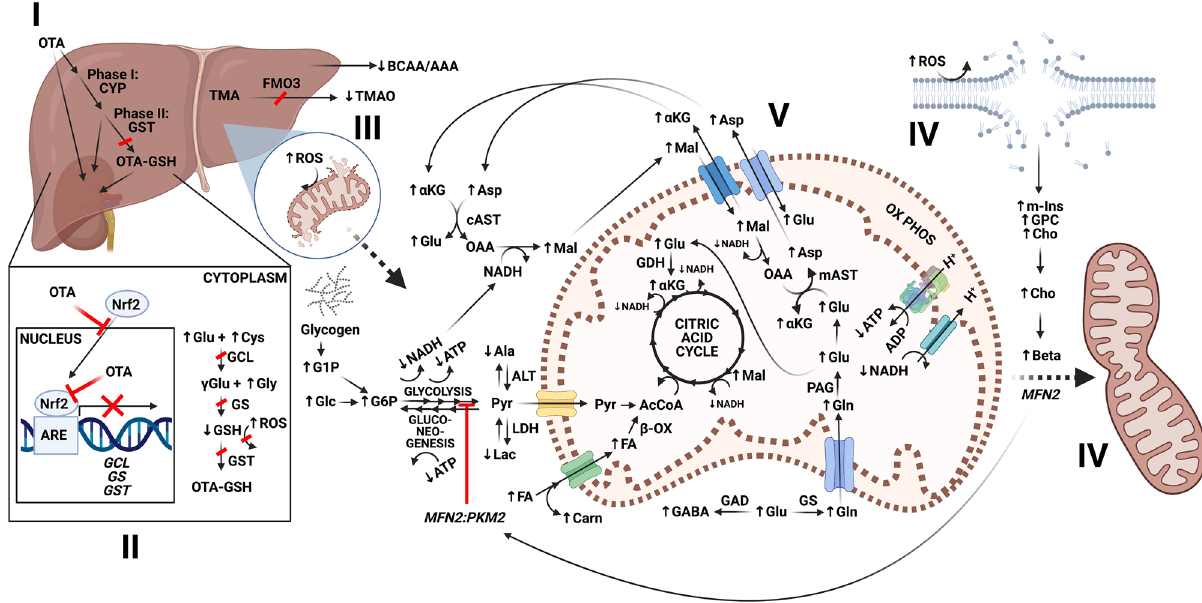
Figure 8. An integrated model of the hepatotoxicity mechanism of ochratoxin A (OTA) in relation to observed changes in metabolic alterations. In liver, OTA affects detoxification pathways ( I ) associated with disruption of Nrf2 that is a key transcriptional factor for regulating detoxification pathways, and the synthesis of GSH as an antioxidant ( II ). This is evident by a decrease in GSH, and increase in its precursors Cys, Glu and Gly. The depletion of GSH leads to impaired redox homeostasis, and an increased production of ROS, and consequently, lipid peroxidation and membrane damage especially affecting mitochondrial membrane integrity ( III ). Mitochondrial membrane hydrolysis is reflected by an increase in Cho, GPC, and m-Ins, as polar headgroups of membrane phospholipids ( IV ). The loss of membrane integrity leads to impairment of the mitochondrial membrane potential (MMP), with consequent reduction of oxidative phosphorylation as reflected by decrease in ATP. Several pathways upstream of oxidative phosphorylation are consequently affected, as seen by changes in metabolites associated with glycolysis and/or gluconeogenesis, the malate/aspartate shuttle, β-oxidation of fatty acids, glutaminolysis, and the citric acid cycle ( V ). The energy deficiency and hindered oxidative phosphorylation activates mitochondrial fusions, possibly via elevated levels of betaine, as a “passive mechanism” to rescue mitochondrial integrity and energy metabolism ( VI ). Observed increases and decreases in metabolites shown by arrows (i.e., ↑ and ↓ , respectively). Abbreviations: CYP = cytochrome P450; GST = glutathione-S-transferase; TCA = Tricarboxylic acid cycle, i.e., citric acid cycle; AcCoA = acetyl CoA; OxPhos = oxidative phosphorylation; PL = phospholipids; BCAA/AAA = ratio of branched chain and aromatic amino acids; FMO3 = flavin-containing monooxygenase 3; LDH = Lactate dehydrogenase; ALT = alanine aminotransferase; TMA = trimethylamine; ARE = antioxidant response elements; OAA = oxaloacetate; cAST = cytosolic Aspartate transaminase; mAST = mitochondrial Aspartate transaminase; MFN2 = mitofusin-2; PKM2 = pyruvate kinase; PAG = phosphate-activated glutaminase; β-ox = Beta oxidation; GAD = glutamate decarboxylase; GS = glutamine synthetase; for other metabolite abbreviations, see legend for Fig.